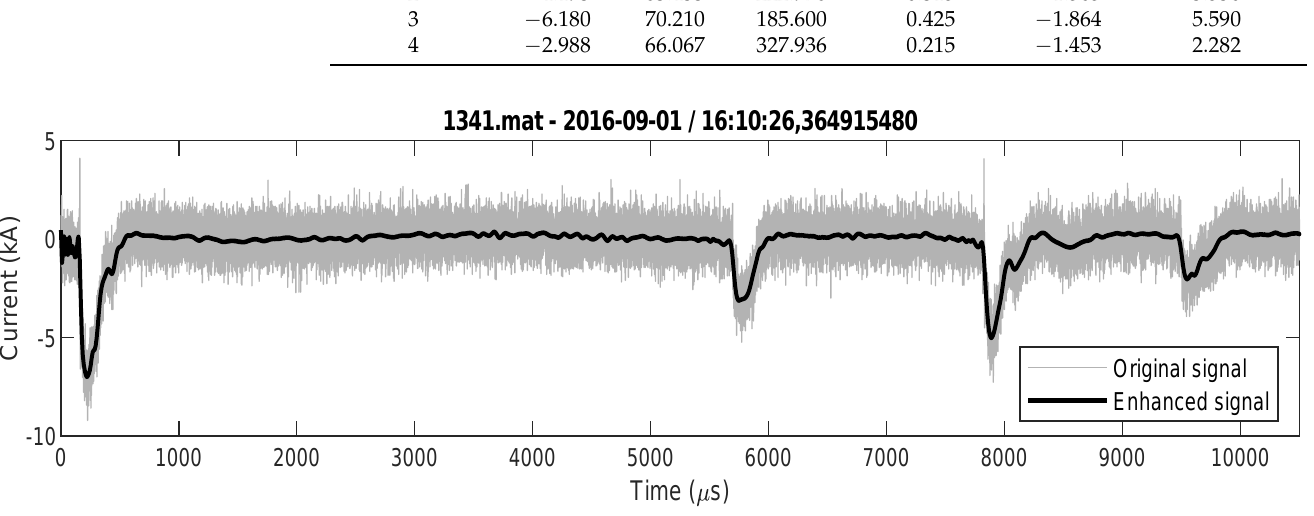
Figure 7. Negative multicomponent lighting flash (flash consists of four strokes) original and enhanced